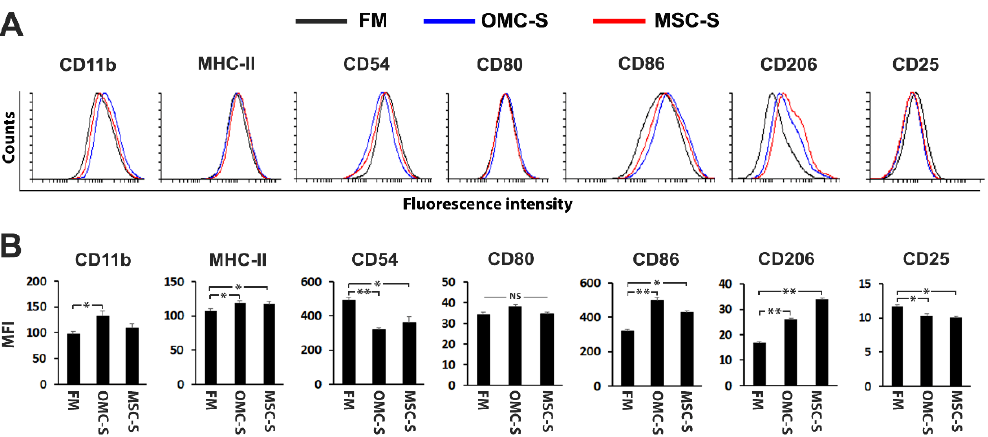
Figure 3 . OMC-derived secretome favors an anti-inflammatory M2 phenotype. ( A , B ) RAW264.7 cells were cultured for 6 days in fresh media (FM) and either OMC- or MSC-derived secretome (OMC-S and MSC-S, respectively). Expression levels of CD11b, MHC-II, CD54 (M1 associated marker), CD80, CD86, CD206 (M2 associated marker), and CD25 were assessed by flow cytometry. ( A ) Representative histograms and ( B ) quantification of mean fluorescence intensity (MFI) are depicted. Isotype histograms are not shown. Results are shown as mean ± s.e.m of ( n = 3) independent batches of OMC-S (from ALIC1, SEV1, and SEV3 OMC lines) and MSC-S production. Statistical differences between conditions were calculated using Student’s t test; * is for p ≤ 0.05; ** is for p ≤ 0.01; NS, not